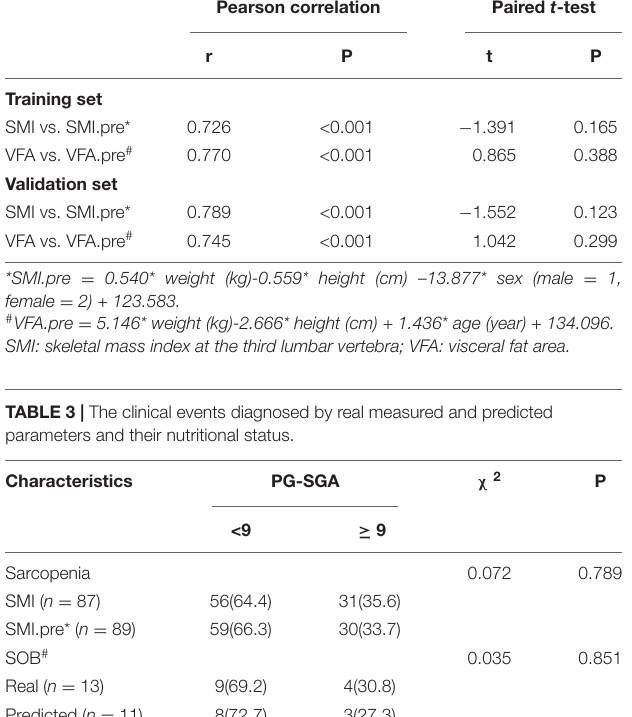
TABLE 2 | Validation of predicting models of SMI and VFA. Pearson correlation Paired t -test